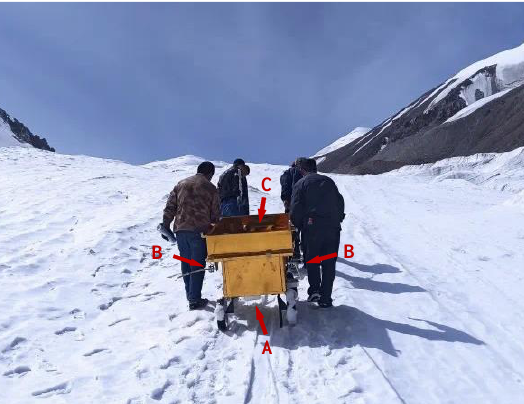
Figure 19. Field experiments were carried out on the Glacier Mengke 29. ( A ) is the high-frequency channel antennas, ( B ) is the low-frequency channel antennas, and ( C ) is the electronic unit.